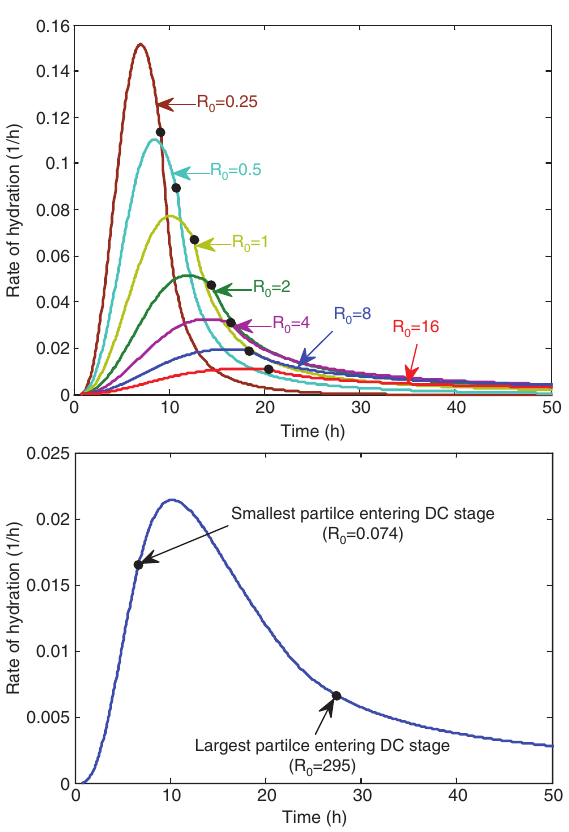
Figure 2: Simulated hydration kinetics of individual cement particles (top) and the weighted average result of a sample with an ensemble of particle sizes (bottom) ( R is the particle radius in μ m, 0 • indicate transition from NG to DC